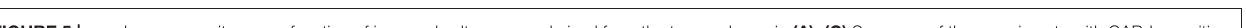
FIGURE 5 | membrane capacitance as function of imposed voltage were derived from the traces shown in (A) . (C) Summary of the experiments with CAP, L-carnitine and CPZ. Ten micromolar CAP induced an increase of normalized maximal in- and outward whole-cell currents (for − 60mV control was set to − 100%; for 130mV control was set to + 100%; n = 13). This increase could be suppressed by 1mM L-carnitine and 10 µ M CPZ, respectively ( n = 5–6). Data passed the normality test and were statistically analyzed using one-way ANOVA (one-way analysis of variance). Selected pairs of columns were tested using Bonferroni post-test. The asterisks (*) designate significance differences between the columns ( n = 5–13; p < 0.05 at the minimum). Significance level alpha = 0.05 (95% confidence intervals). (D) CAP (10 µ M) induced an irreversible increase of intracellular Ca 2 + concentration (n = 55) whereas non-treated control cells maintained a constant Ca 2 + baseline ( n = 9). (E) Same experiment as shown in (D) , but in the presence of L-carnitine. L-carnitine (1mM) suppressed the CAP-induced Ca 2 + increase ( n = 55). (F) Summary of the experiments with CAP and L-carnitine. Data were statistically analyzed using one-way ANOVA (and Nonparametric) (one-way analysis of variance) (Kruskal-Wallis test). Selected pairs of columns were tested using Dunns post-test. The asterisks (*) designate significance differences between the columns ( n = 55; p < 0.005). Significance level alpha = 0.05 (95% confidence